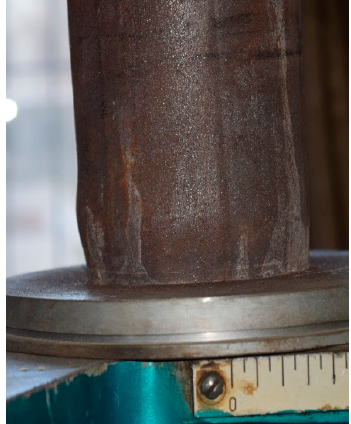
Figure 8. Deformation (expansion) of the specimens.